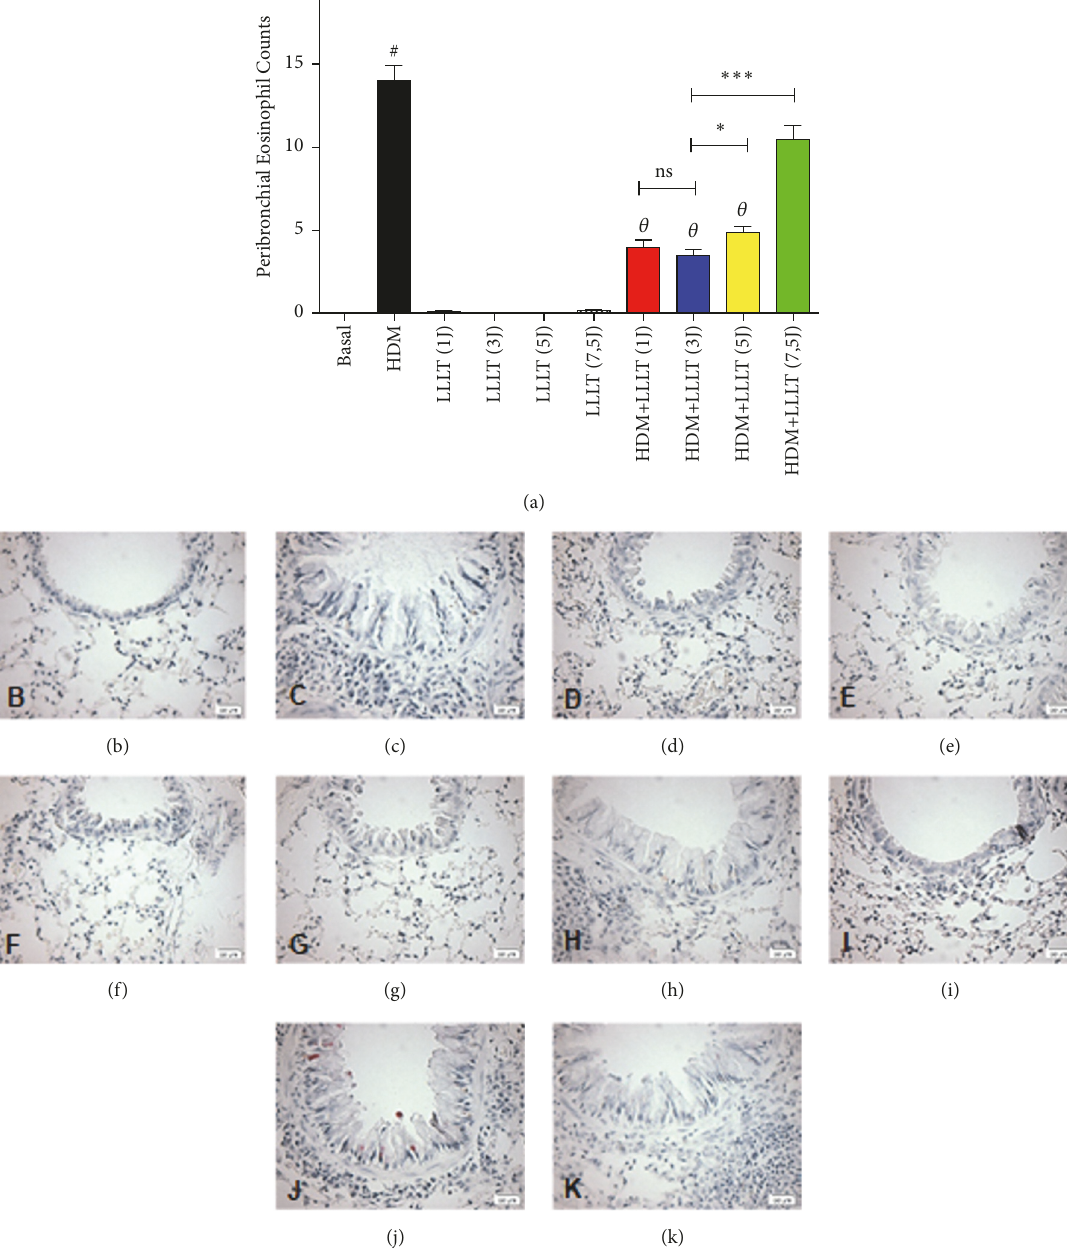
Figure 3: Effect of LLLT on the quantification of peribronchial eosinophils. The lungs were fixed, prepared, and stained with LUNA for the analysis of eosinophils in the airways. The animals were irradiated with LLLT 3x/week for 5 weeks, 1 hour after challenge with HDM. Increase of × 400. Values expressed as mean and standard deviation. The groups used in the experiment are described in Figure 1. The results refer to the use of 10 mice in each experimental group. # p < 0.001 when compared to the Basal group and 𝜃 p < 0.001 when compared to the asthmatic group (HDM) and ns (not significant); ∗ p < 0,05 and ∗ ∗ ∗ p < 0,001 when compared HDM+LLLT (3J) group with the other groups treated with other